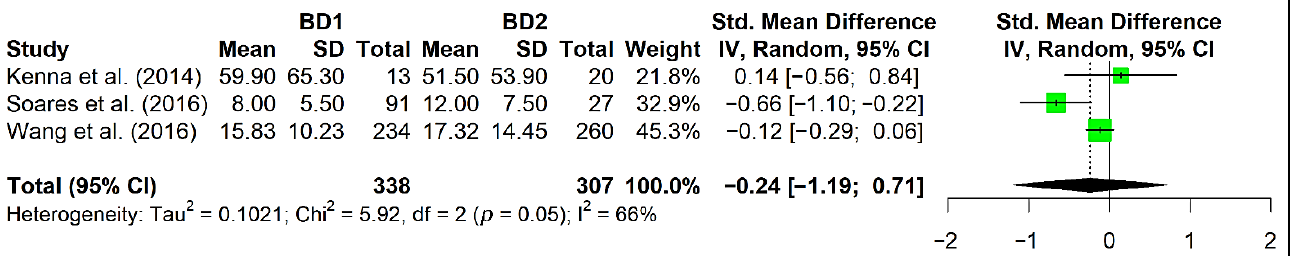
Figure 2. Forest plot of the meta-analysis of BDNF in patients with BD1 subtype compared to those with BD2 subtype in three selected studies (21, 40, 45 in Table 1).